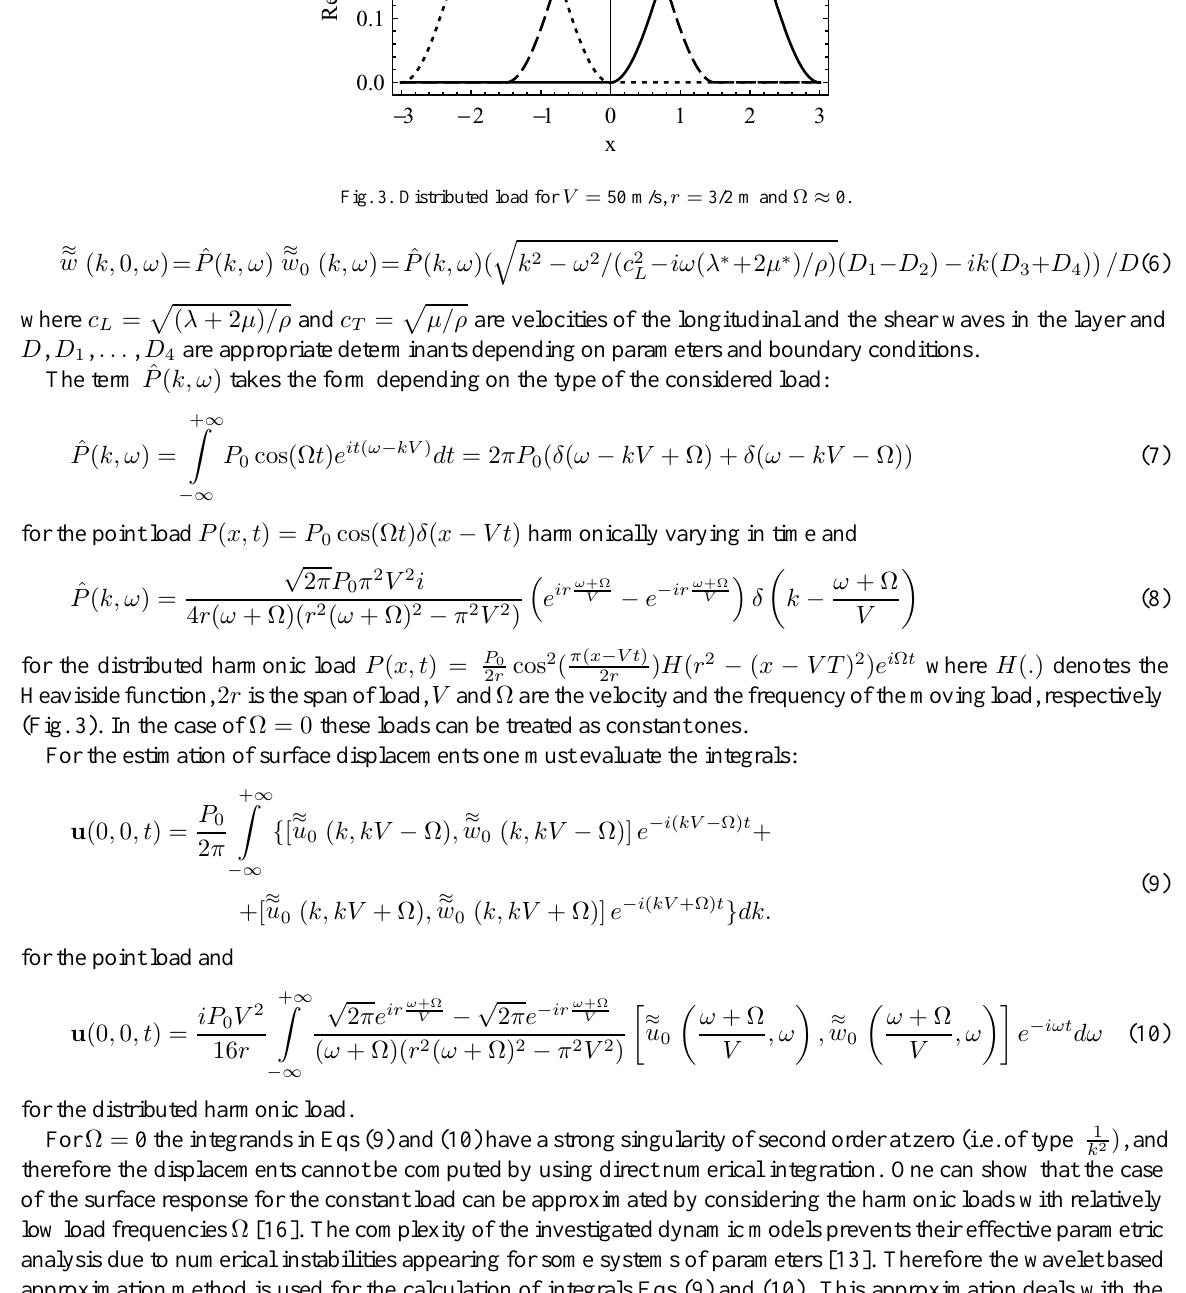
(cid:2) k 2 − ω 2 / ( c 2